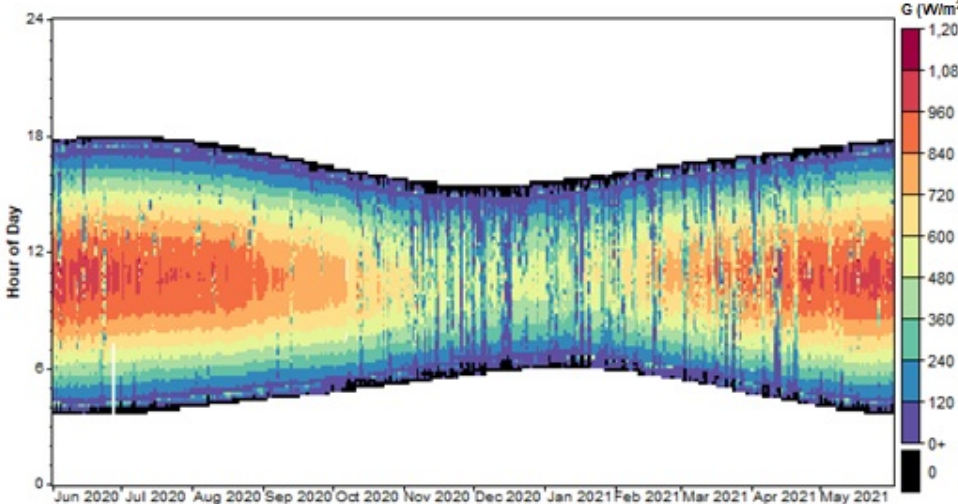
Figure 5. Two-dimensional representation of global radiation ( G ).